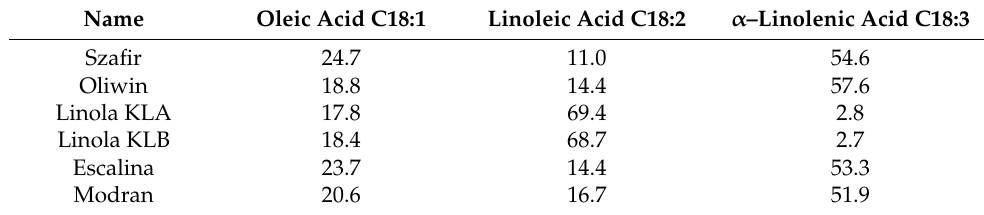
Table 4. The fatty acid compositions in